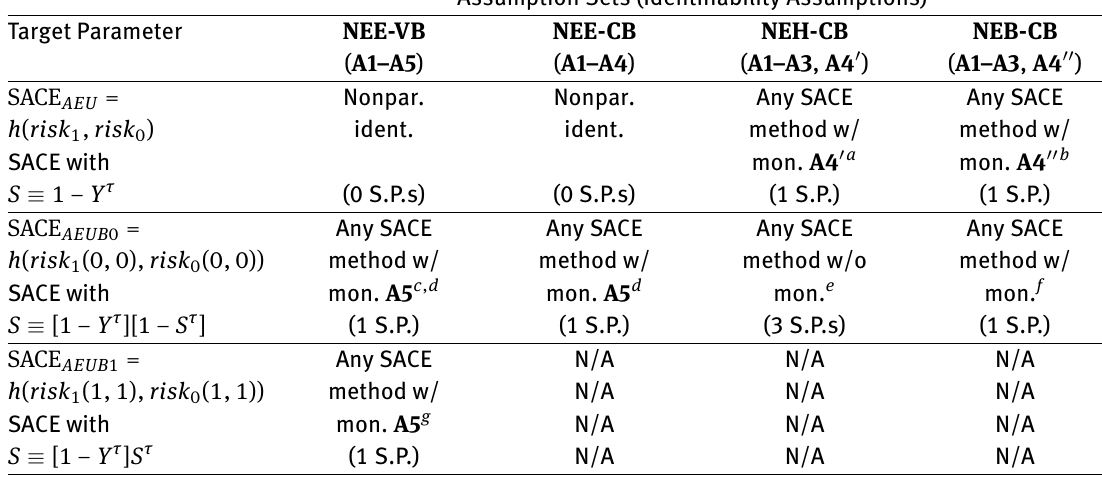
Table 2: Use of SACE Methods [With Numbers of Sensitivity Parameters (S.P.s)] for Estimation of CEP ( s 1 , s 0 ) = h ( risk 1 ( s 1 , s 0 ), risk 0 ( s 1 , s 0 )) for ( s 1 , s 0 ) = (0, 0), (1, 0), (1, 1)